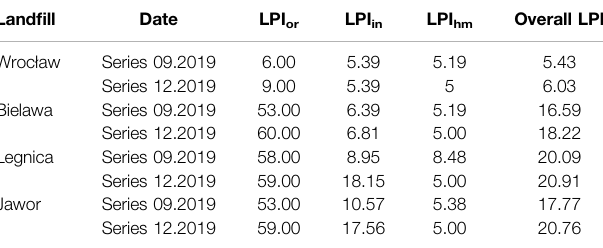
TABLE 4 | Sub-indices of LPI and overall LPI for leachate from active and closed land fi lls. Land fi ll